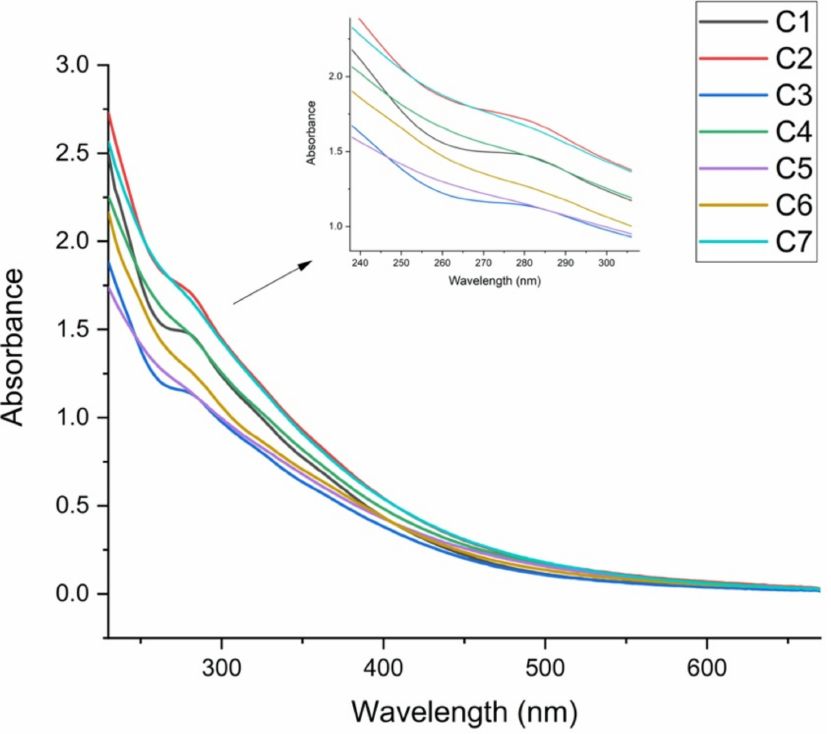
Figure 1. UV–Vis spectra. Compost labels according to the target waste: C1 fish waste; C2 horse manure; C3 sewage sludge; C4 green waste; C5 kitchen biowaste; C6 H. illucens frass; and C7